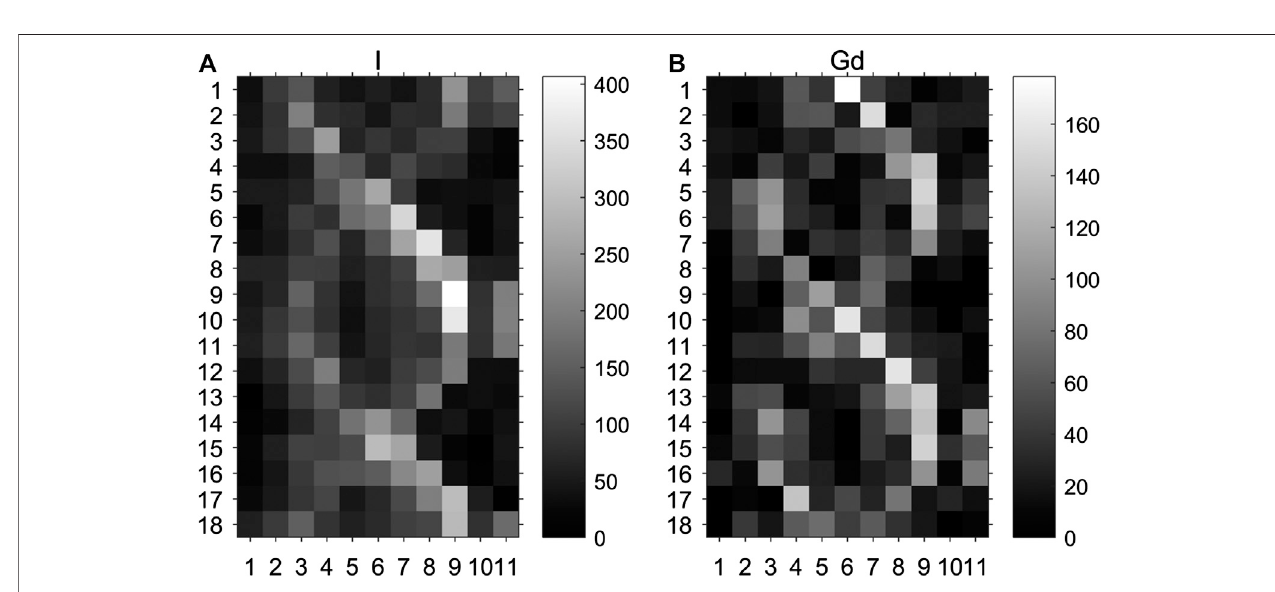
FIGURE 10 | Projection data of the two target elements: (A) I; (B)